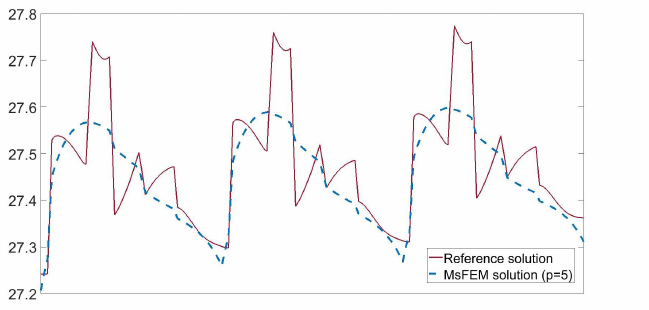
Figure 6. Temperature [°C] along the selected segment (at the half of the specimen height).